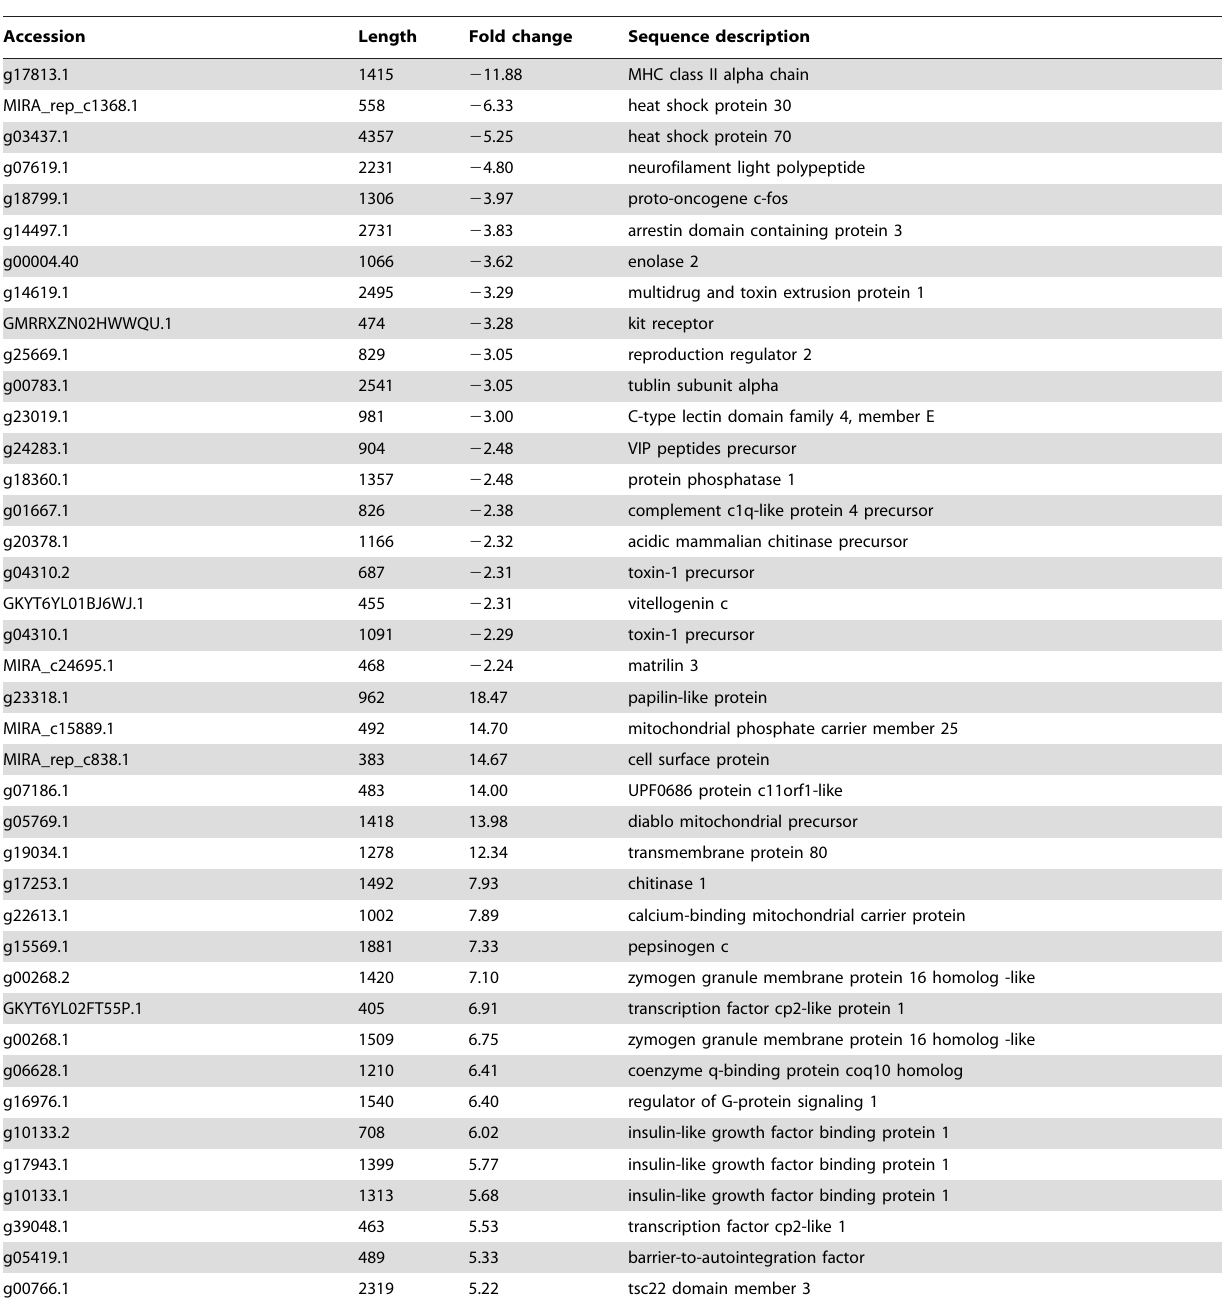
Table 2. Top 20 up-regulated and down-regulated transcripts with functional annotation.